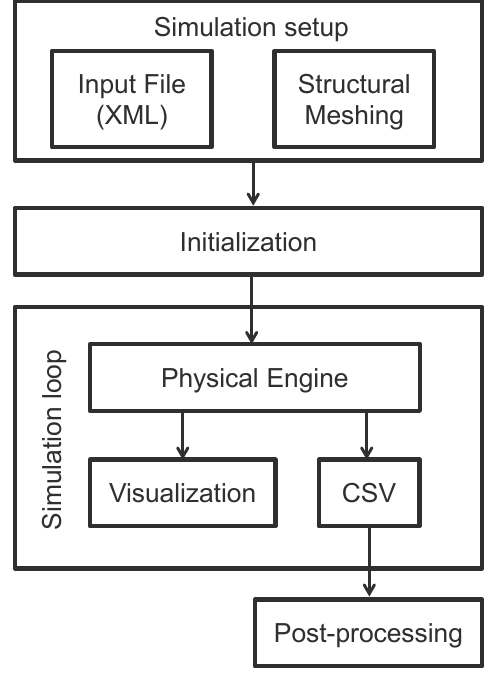
Figure 1: Simulation workflow of the numerical